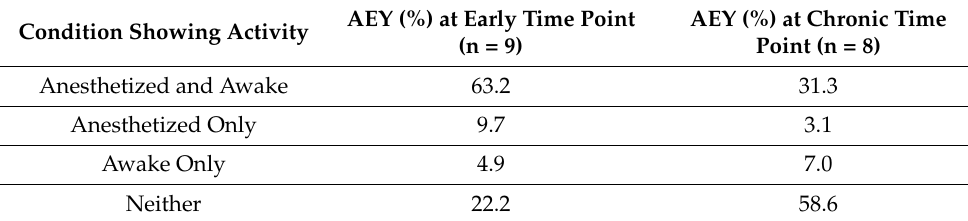
Table 1. AEY of anesthetized and awake conditions for early and chronic time